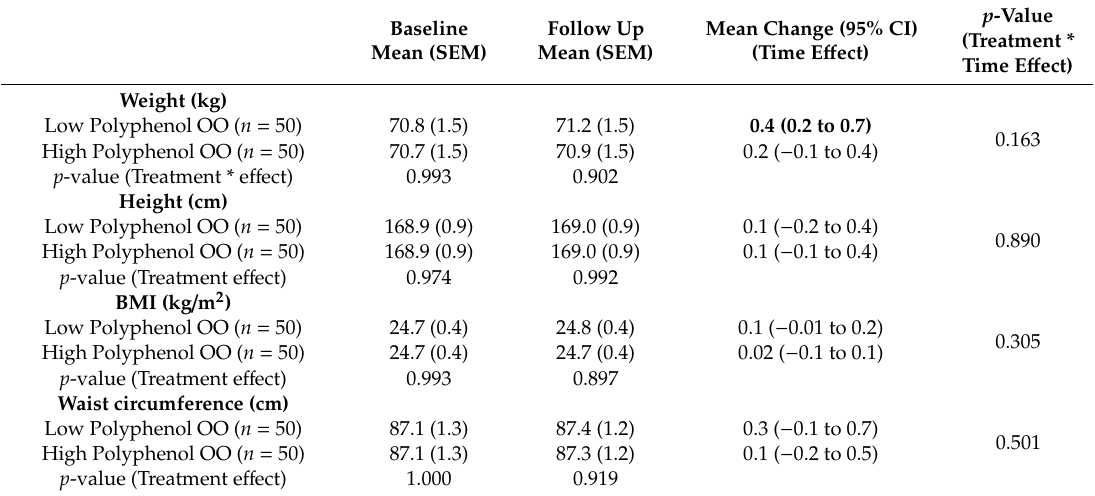
Table 3. Effect of low polyphenol OO vs. high polyphenol OO on mean changes in anthropometric indices.